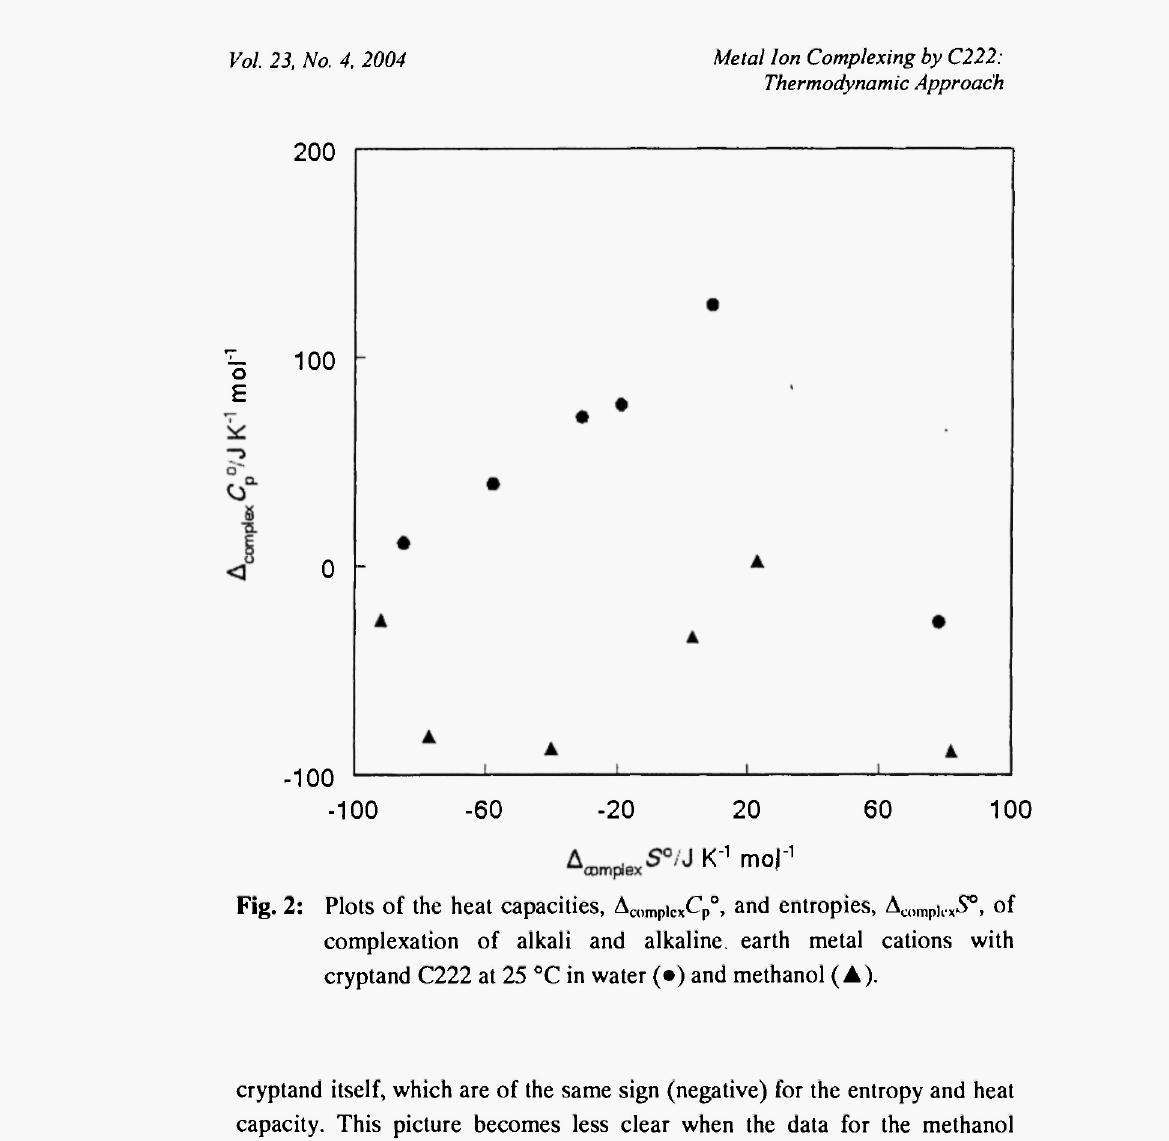
Fig. 2: Plots of the heat capacities, A con)p i cx C p 0 , and entropies, A a)mp:i . x .S' 0 , of complexation of alkali and alkaline, earth metal cations with cryptand C222 at 25 °C in water ( ·) and methanol